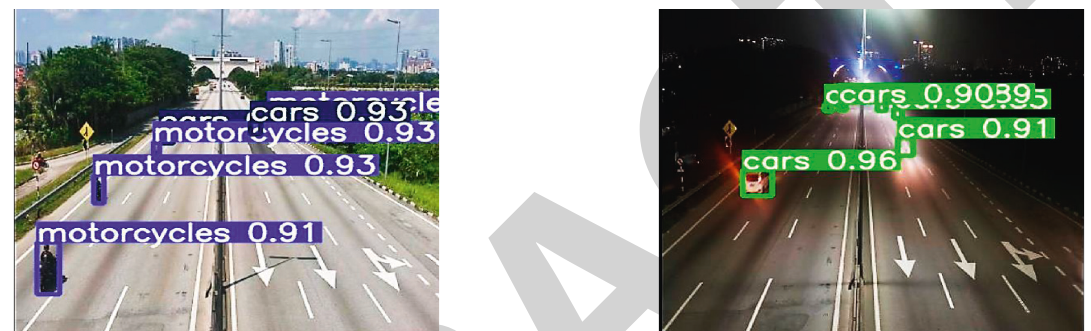
Figure 13: Model detecting motorcycle class in daytime dataset (A).